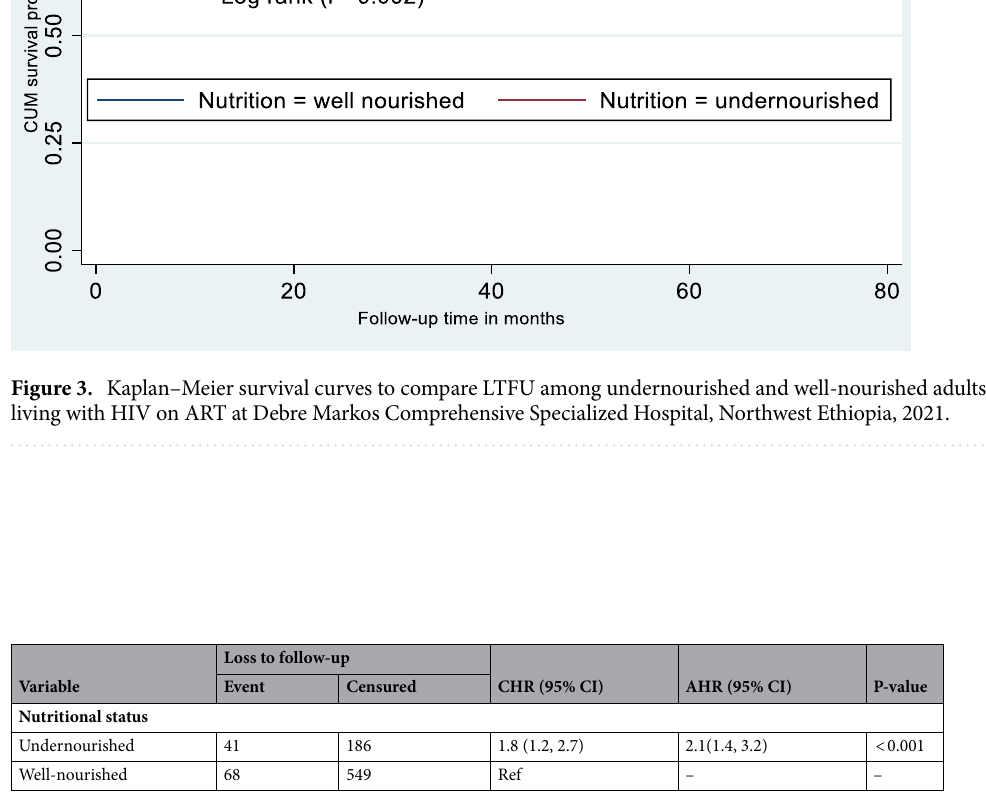
Table 3. The effect of undernutrition on LTFU among adults living with HIV on ART at Debre Markos Comprehensive Specialized Hospital, Northwest Ethiopia, 2021.